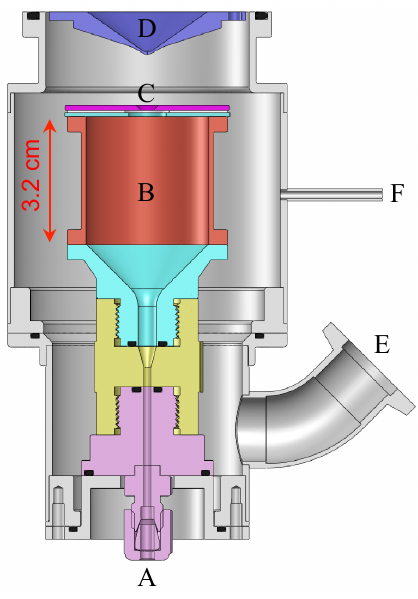
Fig. 3. Custom ion source for the CIMS H 2 O measurement. Air enters the ion source chamber through a capillary connected to the fitting (A) at the bottom. The 241 Am foil is located on the inside of the ion source chamber (B), which is held at a + 140V potential with respect to ground. Positive ions formed inside the chamber are extracted through the exit lens (C) by applying a + 90V potential to the lens ( − 50V relative to the chamber). The ions exit the chamber directly in front of the entrance nose cone of the mass spectrometer (D), which is held near ground potential. Air flowing through the ion source chamber is pumped away through port (E) on the vacuum can, while the pressure is monitored through a smaller port